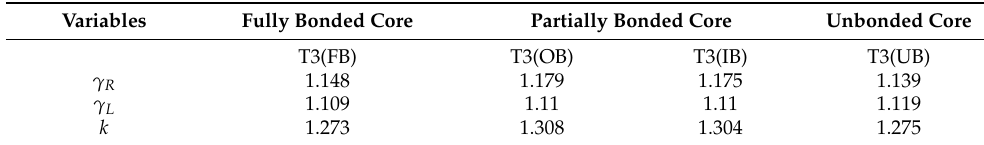
Table 7. Partial safety factors for SP for different inter-layer adhesion